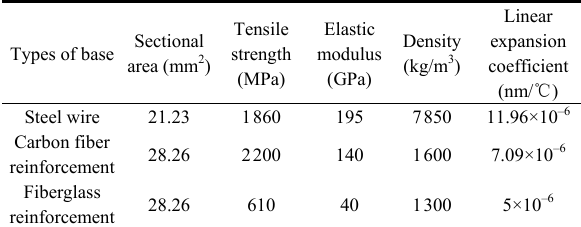
Table 1 Relevant properties of substrate